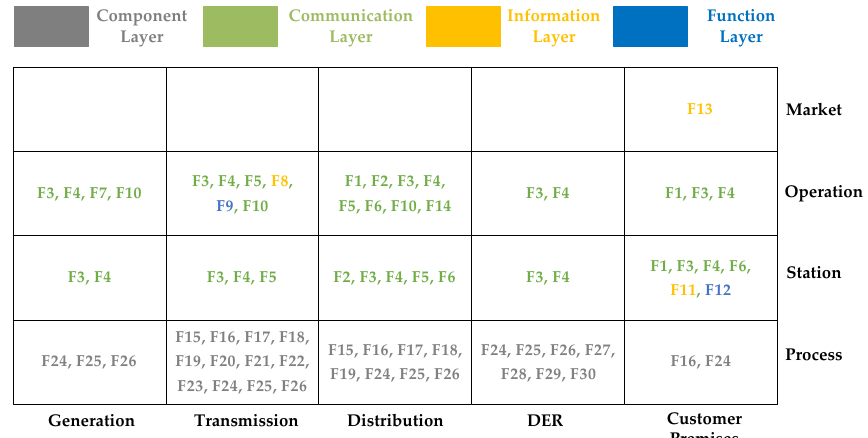
Fig. 3 RQ2. Mapping of faults and failures to SGAM domains, zones and